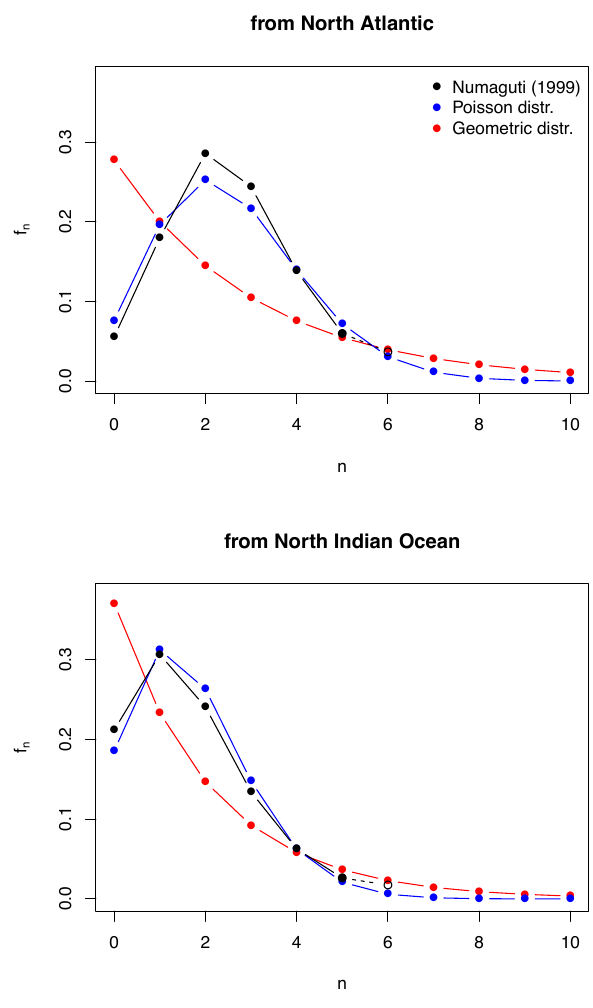
Fig. 1. Frequency distributions of the number of continental re- cycling events ( n ) for July precipitation in the eastern Tibet re- gion. Top: precipitation stemming from the North Atlantic. Bottom: precipitation stemming from the North Indian Ocean. Black: sim- ulated frequencies for n = 0 , 1 , 2 , 3 , 4 , 5 and n ≥ 6, derived from Fig. 14 in Numaguti (1999). Blue: fitted Poisson distributions with mean values λ = 2 . 57 (top) and λ = 1 . 69 (bottom). Red: fitted ge- ometric distributions with mean values r/( 1 − r) = 2 . 61 (top) and r/( 1 − r) = 1 . 70 (bottom).